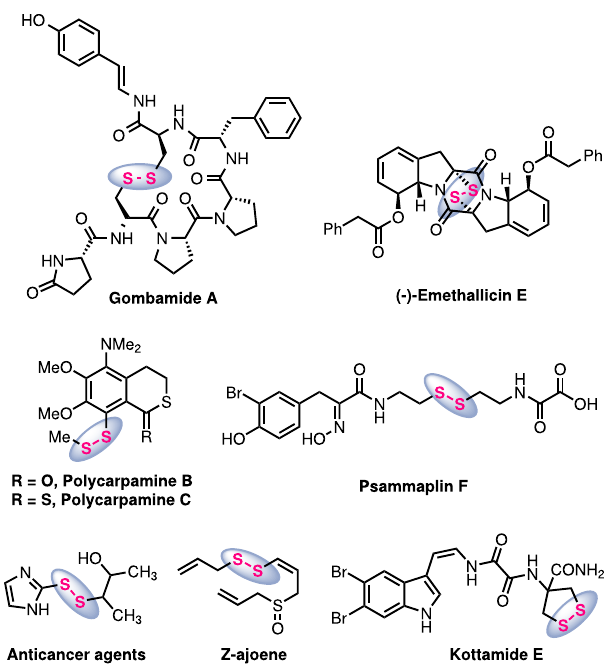
Fig. 1 The disul fi de moiety in natural products and drugs. Unsymmetrical disul fi des in natural products and